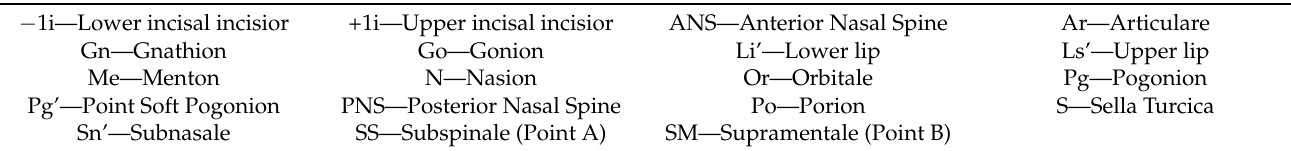
Table 1. A list of 19 cephalometric landmarks annotated in the ISBI public database. A description of the landmarks and their significance can be found in